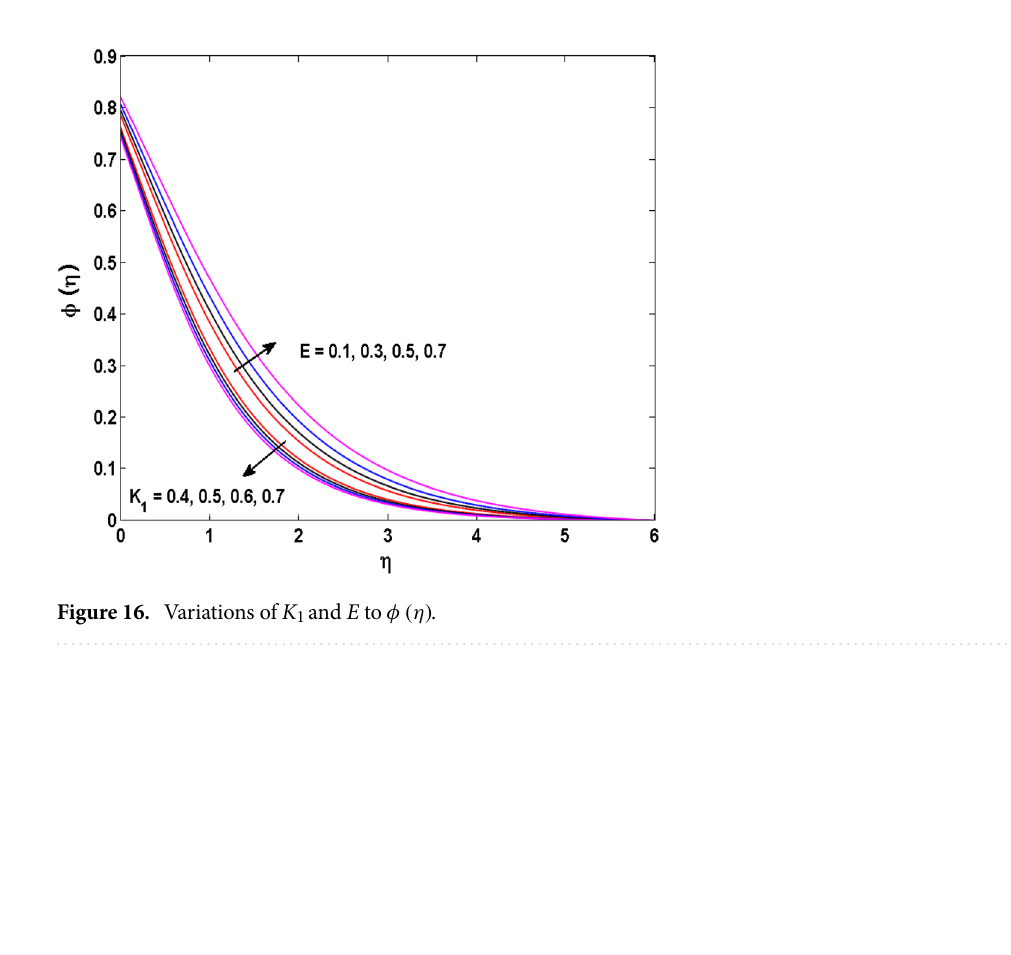
Figure 15. Variations of n to φ (η) .